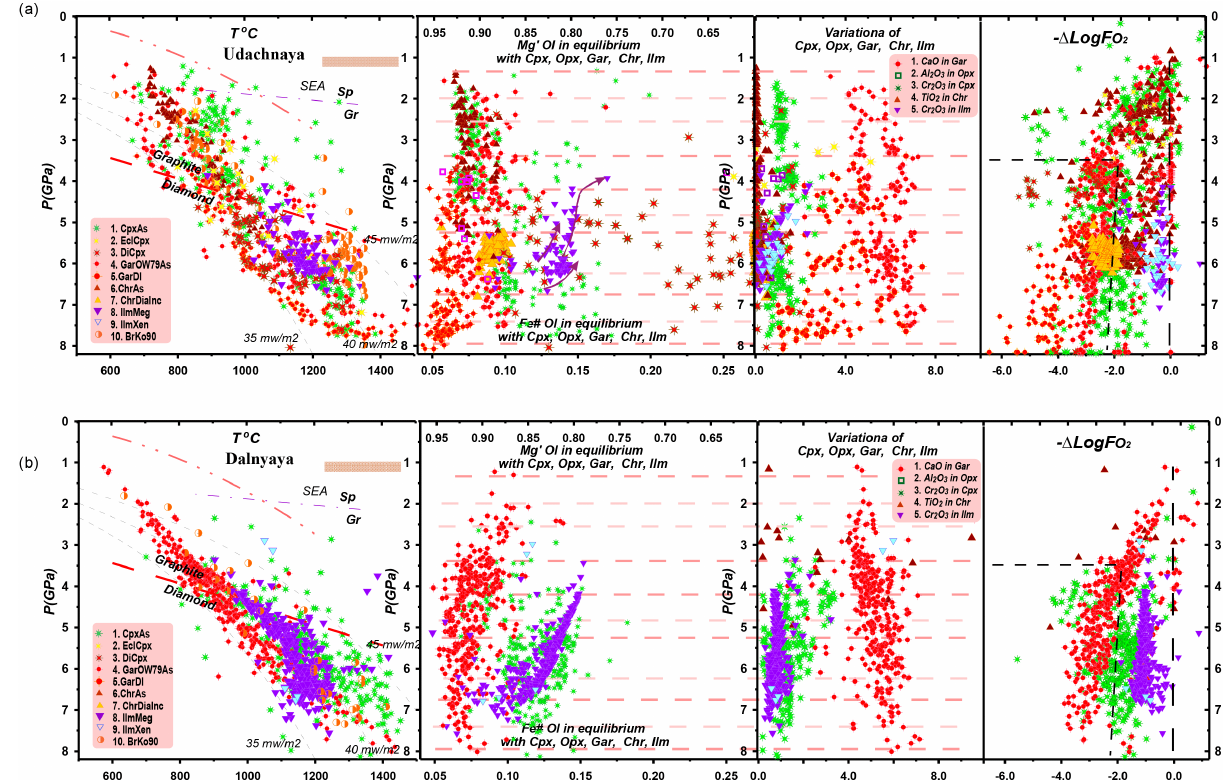
Figure 9. (a) PTXfO 2 estimates for the minerals from xenocrysts and xenoliths from Udachnaya pipe, Daldyn field. Fe# is calculated Fe number of olivines, coexisting with garnets, pyroxenes chromite and ilmenites. 1. Clinopyroxene thermobarometry T ◦ C (Nimis and Taylor, 2000) – P (GPa) (Ashchepkov, 2003) for xenoliths (Boyd et al., 1997; Pokhilenko et al., 2000; Malygina, 2005; Pokhilenko et al., 2007); 2. The same for common eclogites; 3. The same for diamond inclusions (Beard et al., 1996; Snyder et al., 1997; Taylor et al., 2003; Sobolev et al., 1997, 2003, 2004; Logvinova et al., 2005); 4. Garnet thermobarometry: T ◦ C (O’Neil, Wood, 1979 monomineral) – P (GPa) (Ashchepkov, 2010; 12); 5. The same for diamond inclusions; 6. Cr-spinel thermobarometry: T ◦ C (Taylor et al., 1998) – P (GPa) (Ashchepkov et al, 2010); 7. The same for diamond inclusions; 8. Ilmenite thermobarometry: T ◦ C (Taylor et al., 1998) – P (GPa) (Ashchepkov et al., 2006) for grains from heavy mineral separates; 9. The same for ilmenites from xenoliths (Alymova, 2006); 10. Brey and Kohler (1990). Line of diamond-graphite boundary after (Kennedy and Kennedy, 1976). (b) PTXfO 2 estimates for minerals from xenocrysts and xenoliths from Dalnyaya pipe. Symbols are the same as for (a)